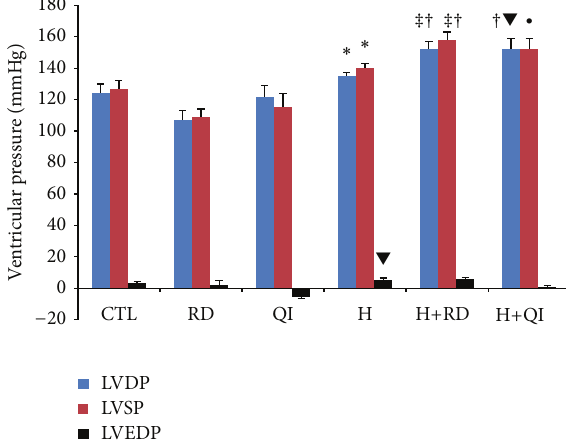
Figure 3: The arterial blood pressure in the different groups. The values are Mean ± SEM. 𝑛 = 6 ; S: systolic pressure; D: diastolic pressure; MAP: mean arterial pressure; CTL: control; RD: Rosa damascena L.; QI: Quercus infectoria ; H: Hyperlipidemic; H+RD: Hyperlipidemic+RD; H+QI: Hyperlipidemic+QI. ∙ 𝑃 < 0.05 versus the H and CTL groups; 󳶃 𝑃 < 0.001 versus the RD group, † 𝑃 < 0.01 versus the RD group; ∗ 𝑃 < 0.05 versus the CTL; o 𝑃 < 0.01 versus the RD group.